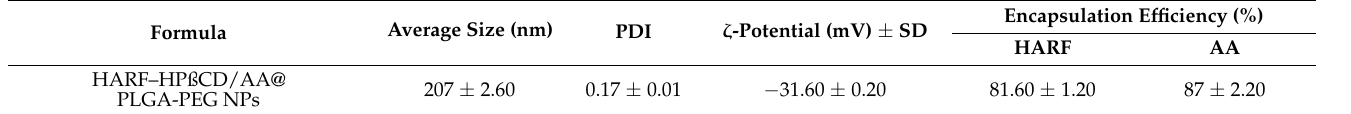
Table 2. Average particle size, PDI, ζ -potential, and entrapment efficiency of HARF–HPßCD/AA@PLGA- PEG